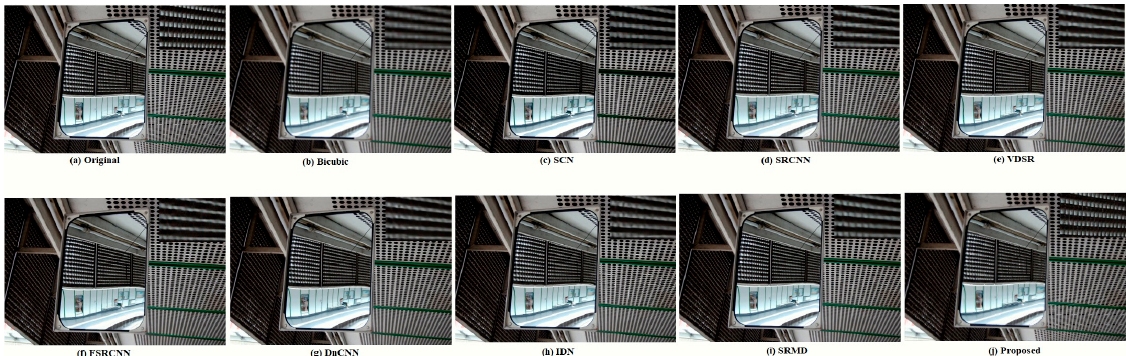
Figure 9. Visual comparison for the man image at the scale-up factor of 3.